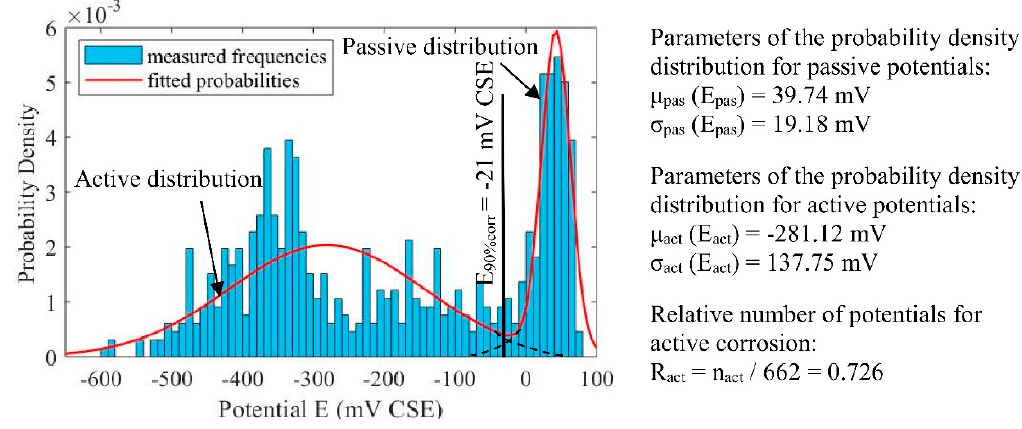
Figure 14. Frequency density distribution of measured and fitted potentials assuming similar moisture conditions near supports. Parameters of the potential distributions.